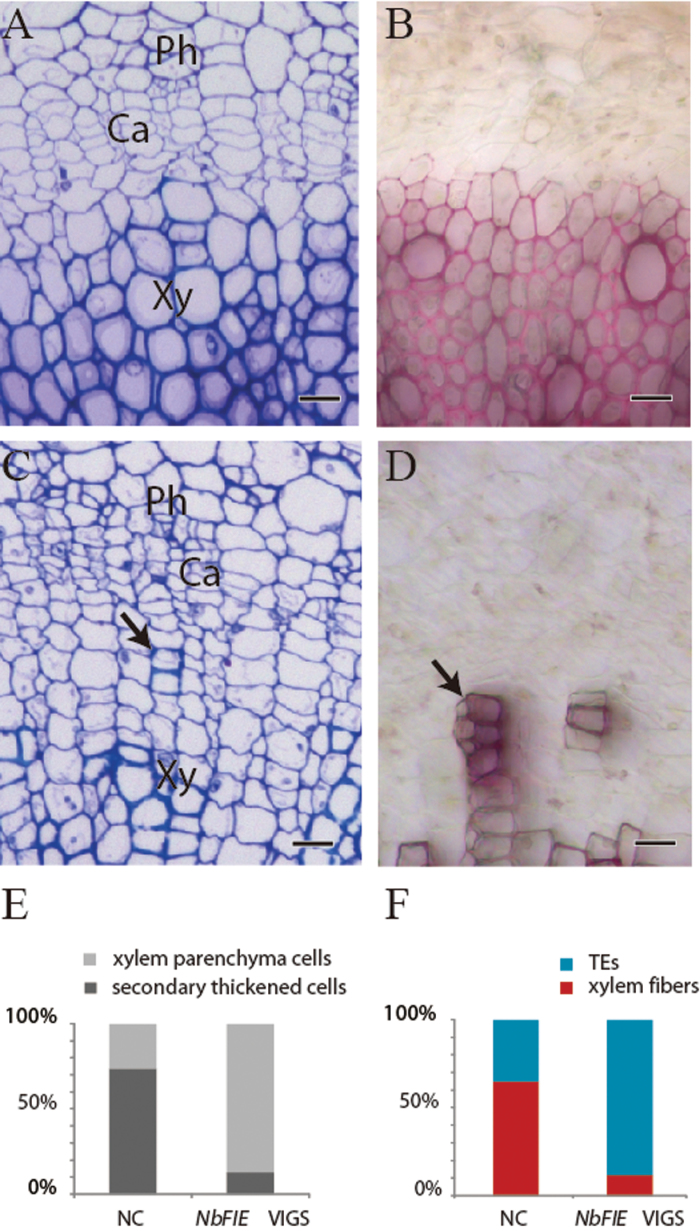
Anatomical analyses of secondary xylem differentiation. Cross sections of the first internode above the cotyledons in a control plant (A, B) and in an NbFIE-silenced plant (C, D) at 24 DAI. (A, C) plastic sections stained by Toluidine blue O. (B, D) Hand cross sections stained with Phloroglucinol-HCl. The arrow in (C) indicates dispersed secondary thickened cells. The arrow in (D) indicates dispersed lignified cells. (E) Ratios of secondarily thickened cells to xylem parenchyma cells. (F) Ratios of tracheary elements to xylem fibres in the population of secondarily thickened cells. NC, negative control plants; NbFIE VIGS, NbFIE-silenced plants. Bars in (A–D), 50 μm.